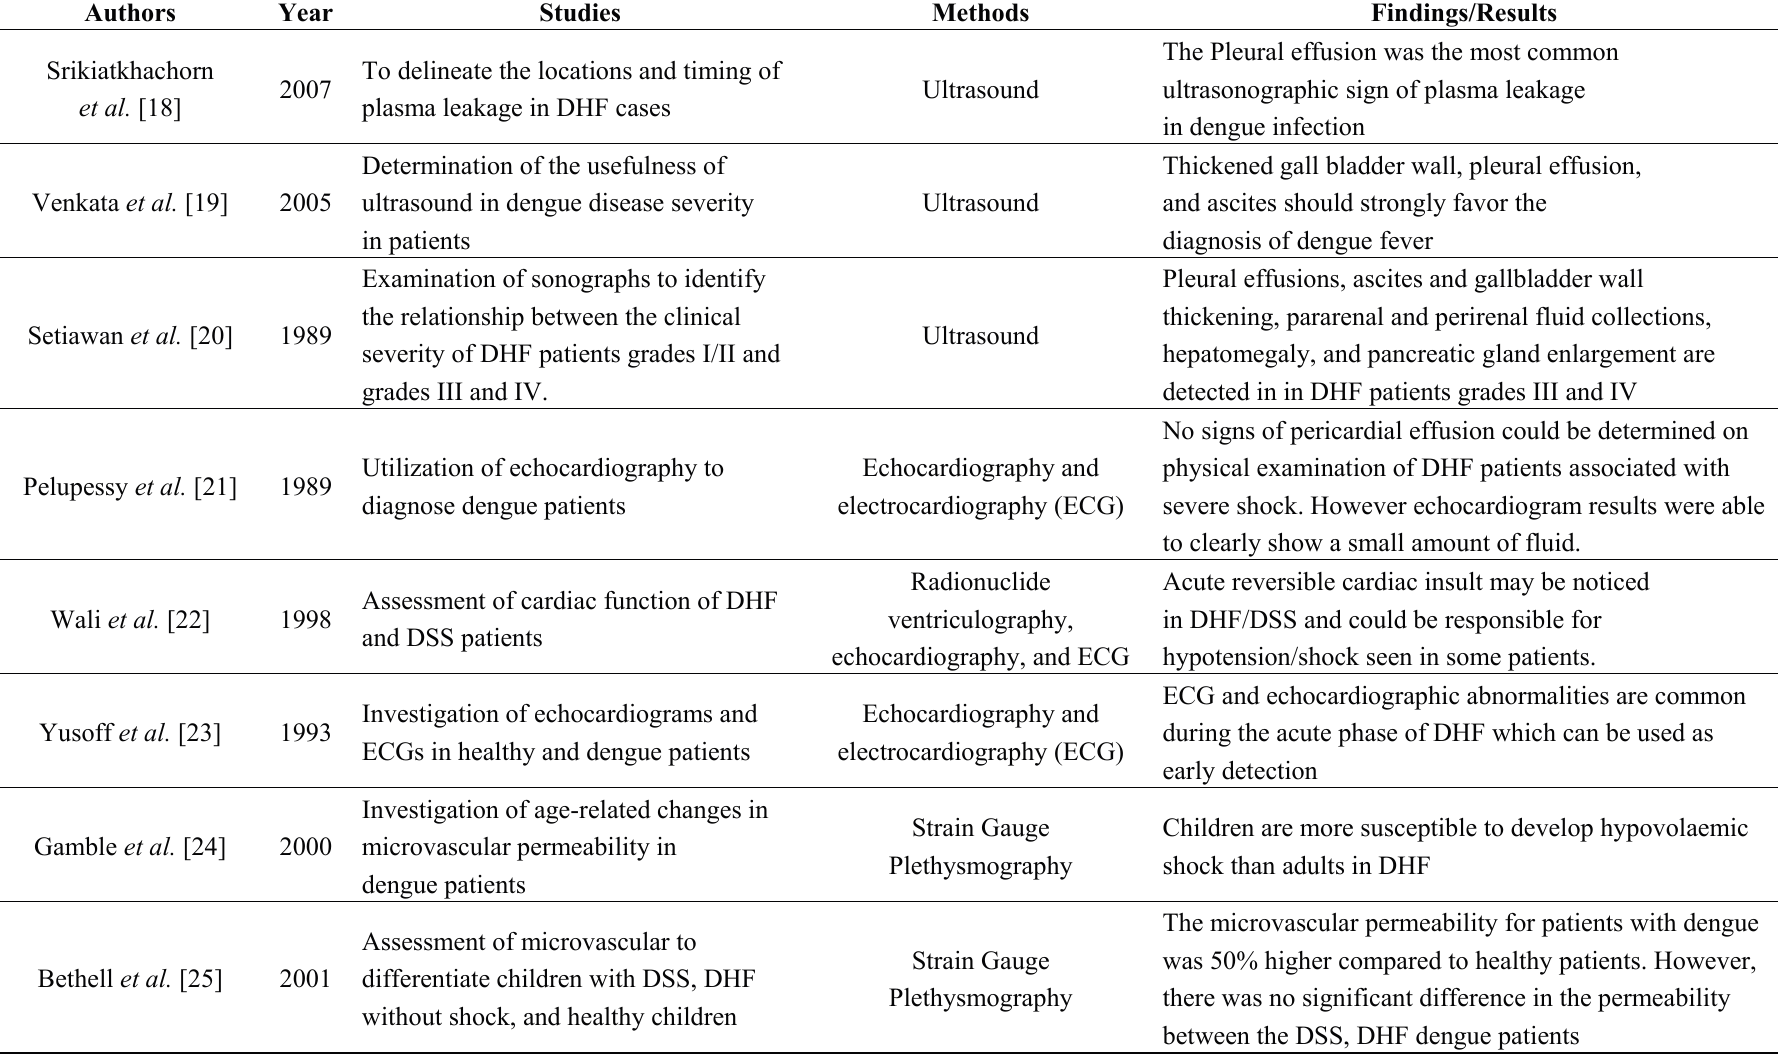
Table 2. Summary of biomedical engineering techniques of ultrasound, echocardiography and electrocardiography (ECG), strain gauge plethysmography, laser Doppler velocimetry and bioelectrical impedance in dengue